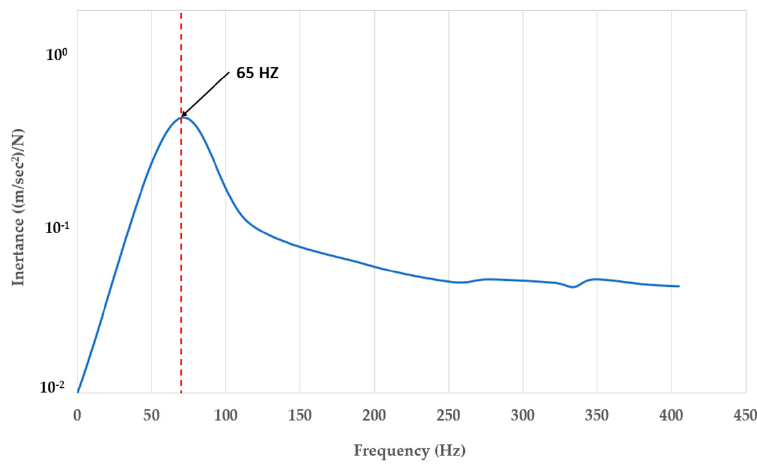
Figure 19. Fundamental resonance frequency of SDOF of the bearing system resulting from the modal testing. Table 2. Comparison of fi rst natural frequencies of the proposed bearing under dry condition, being on a ground (without a plastic box) between experimental and numerical results.